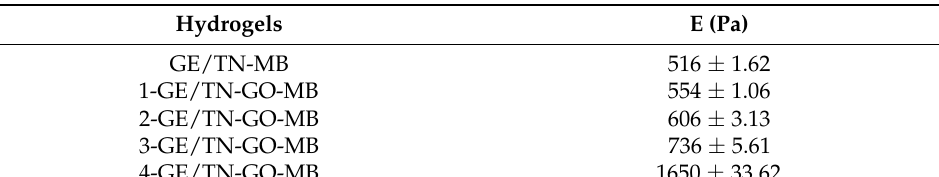
Table 1. Young’s modulus in the wet hydrogels.